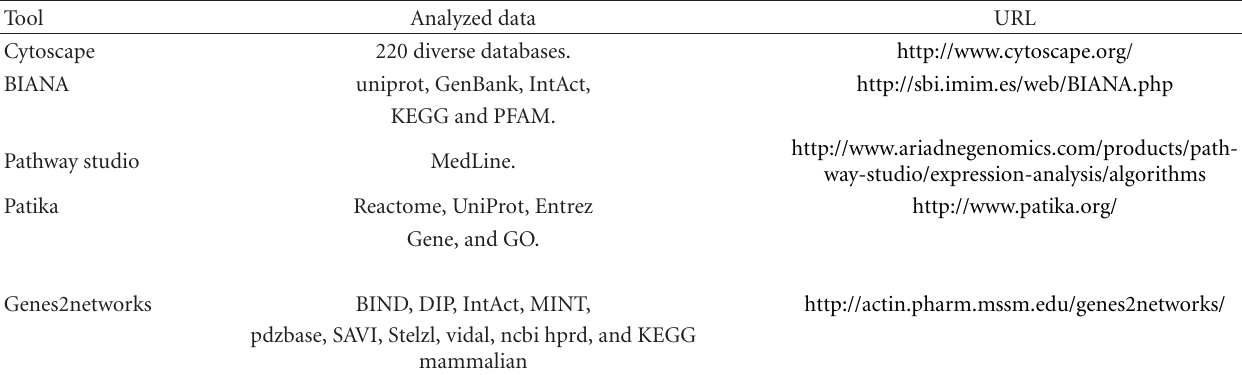
Table 2: Examples of tools to analyze biological pathways.